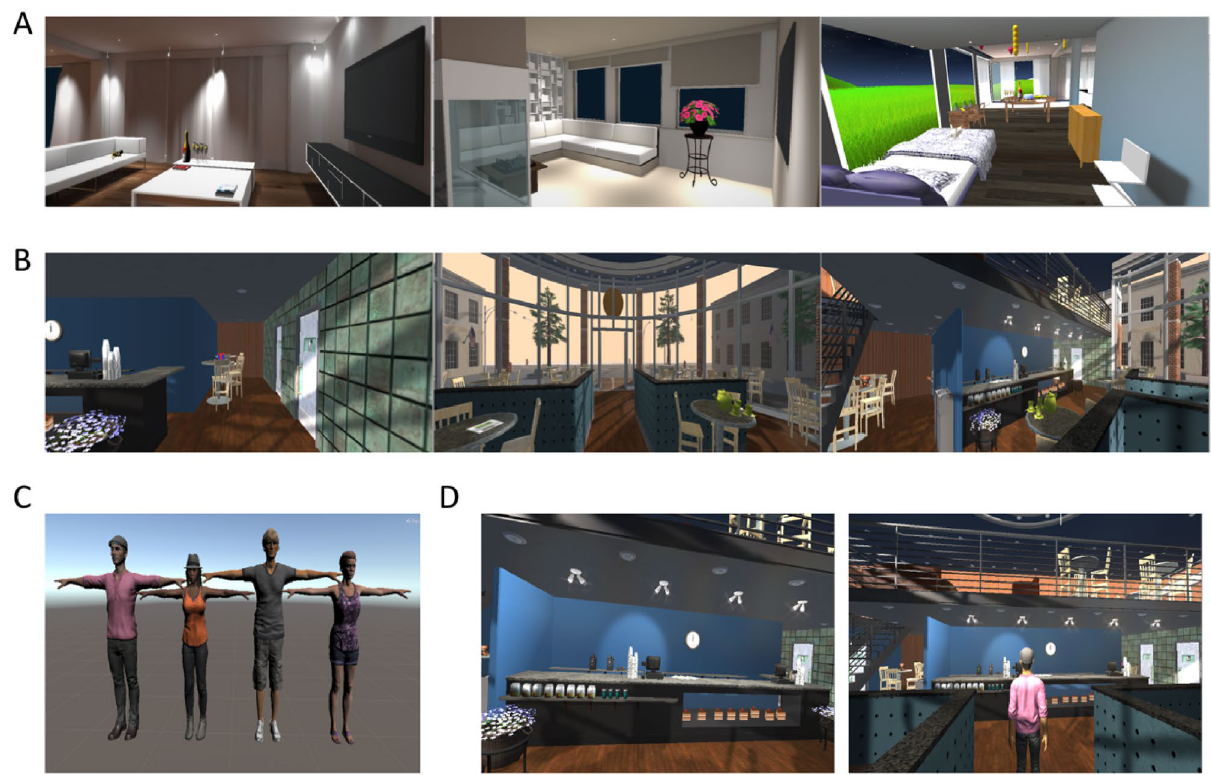
Figure 1. Study one virtual environments and avatars. ( A ) Screenshots from the virtual house environment. ( B ) Screenshots from the virtual café environment. ( C ) Four avatars that participants could choose from. ( D ) Screenshots of the first-person (left) and third-person (right) avatar